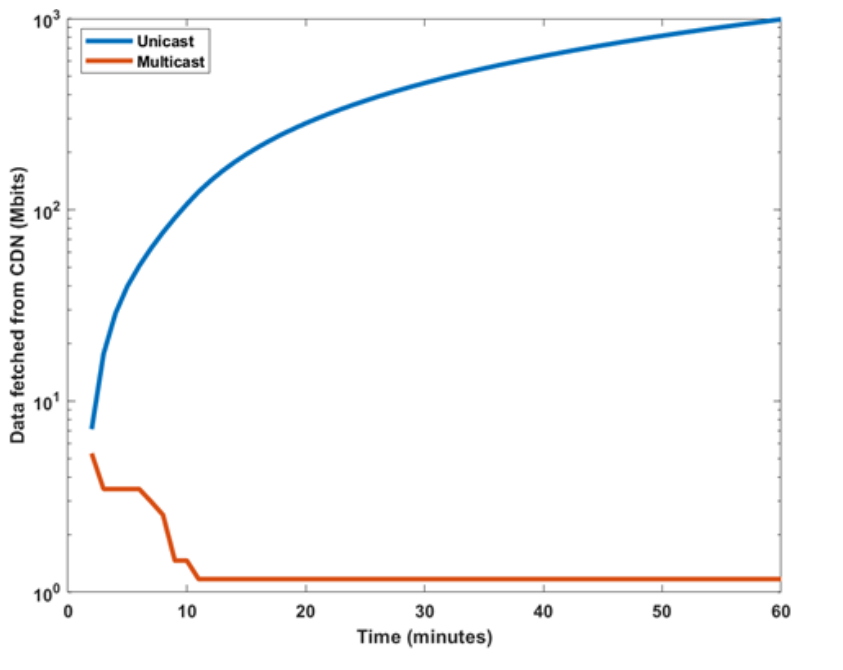
Figure 3. Data fetched from CDN.